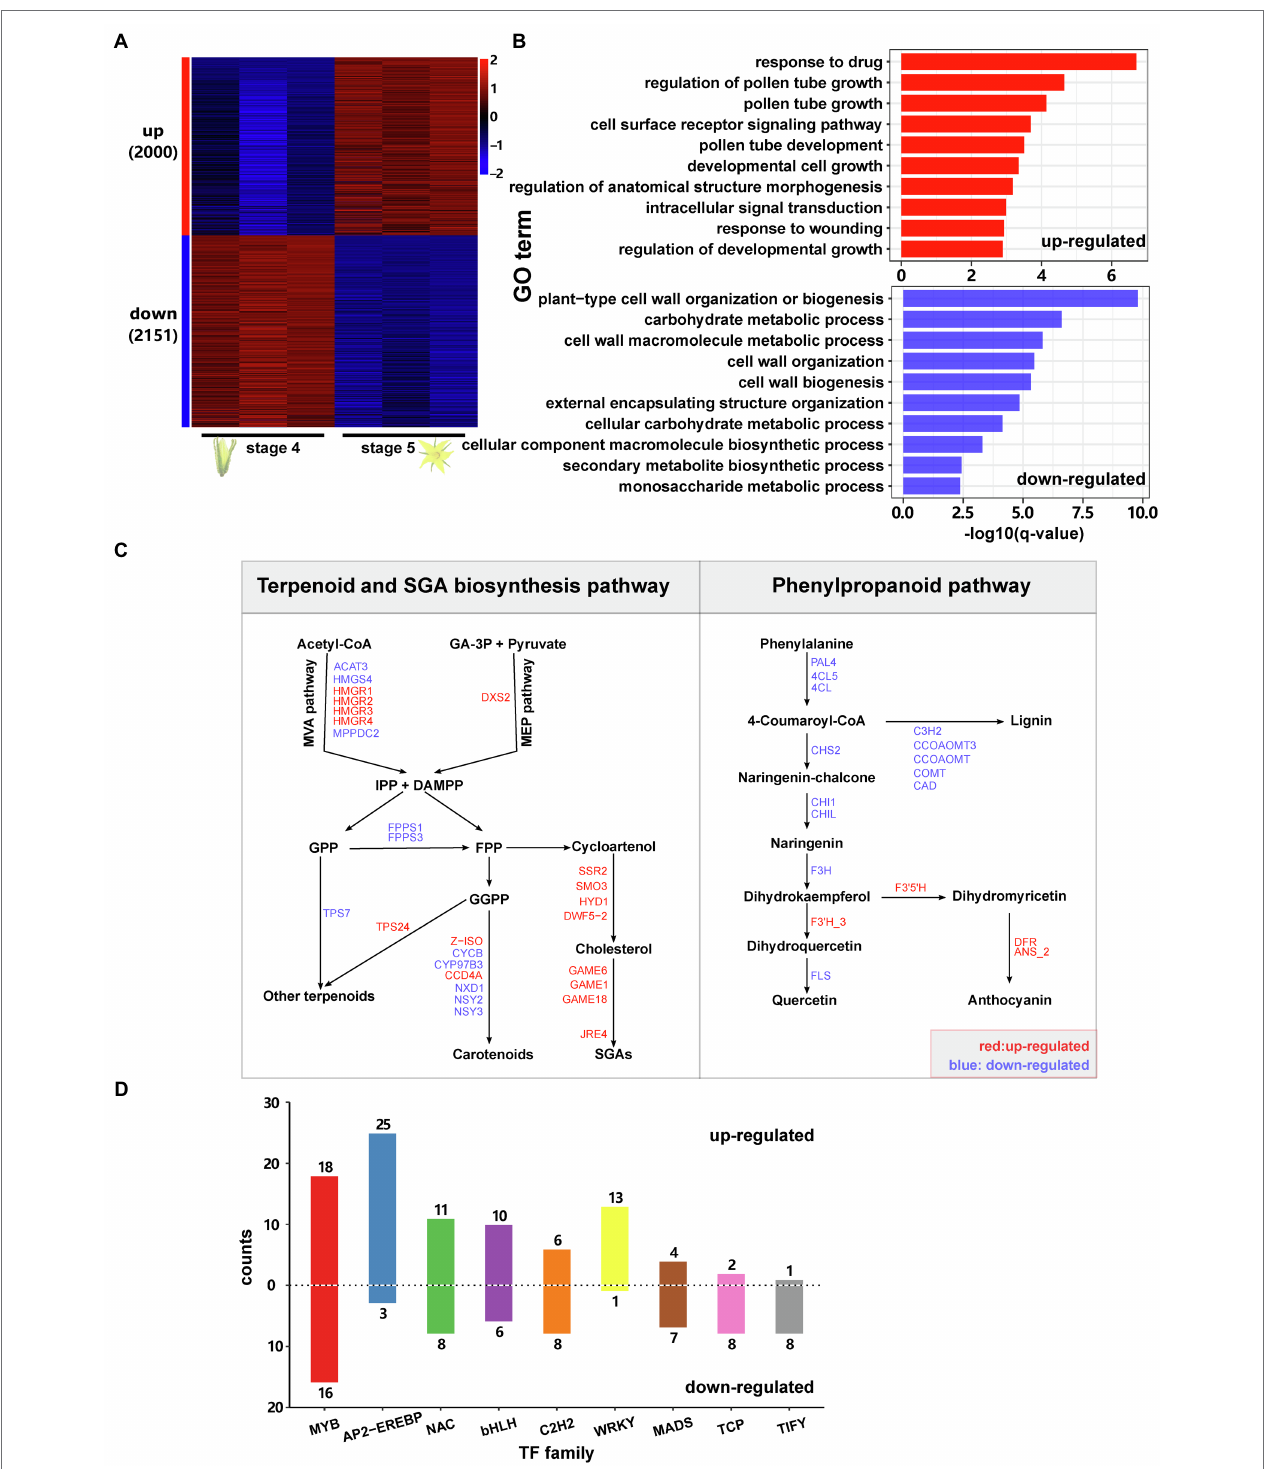
FIGURE 2 | Transcriptomic reprogramming during flower development in tomato. (A) Heat map showing the expression patterns of flowering-associated genes in domesticated tomato. ‘up’ means upregulated during flower development, and ‘down’ means downregulated during flower development. The numbers in brackets are the corresponding gene numbers. For each stage, there were three replicates. Gene expression levels were log 10 -transformed and z-score normalised. (B) GO enrichment analysis for flowering-associated genes. Only the top ten most enriched GO terms are shown in the plots. (C) Expression patterns of flowering-associated genes involved in the terpenoid, SGA and phenylpropanoid pathways. Only genes showing significantly differential expression during flower development